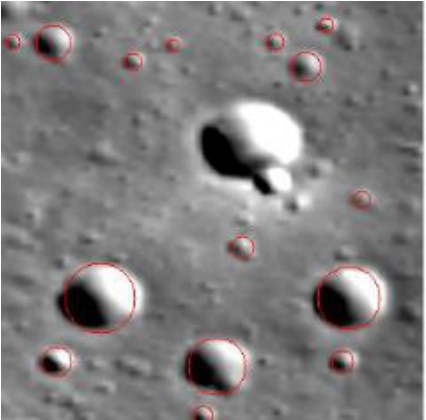
Figure 2. Effect picture of extraction algorithm based on feature matching (N39°-40° ， E323°-324°, the center wavelength is 1548nm, the spatial resolution is 62m)